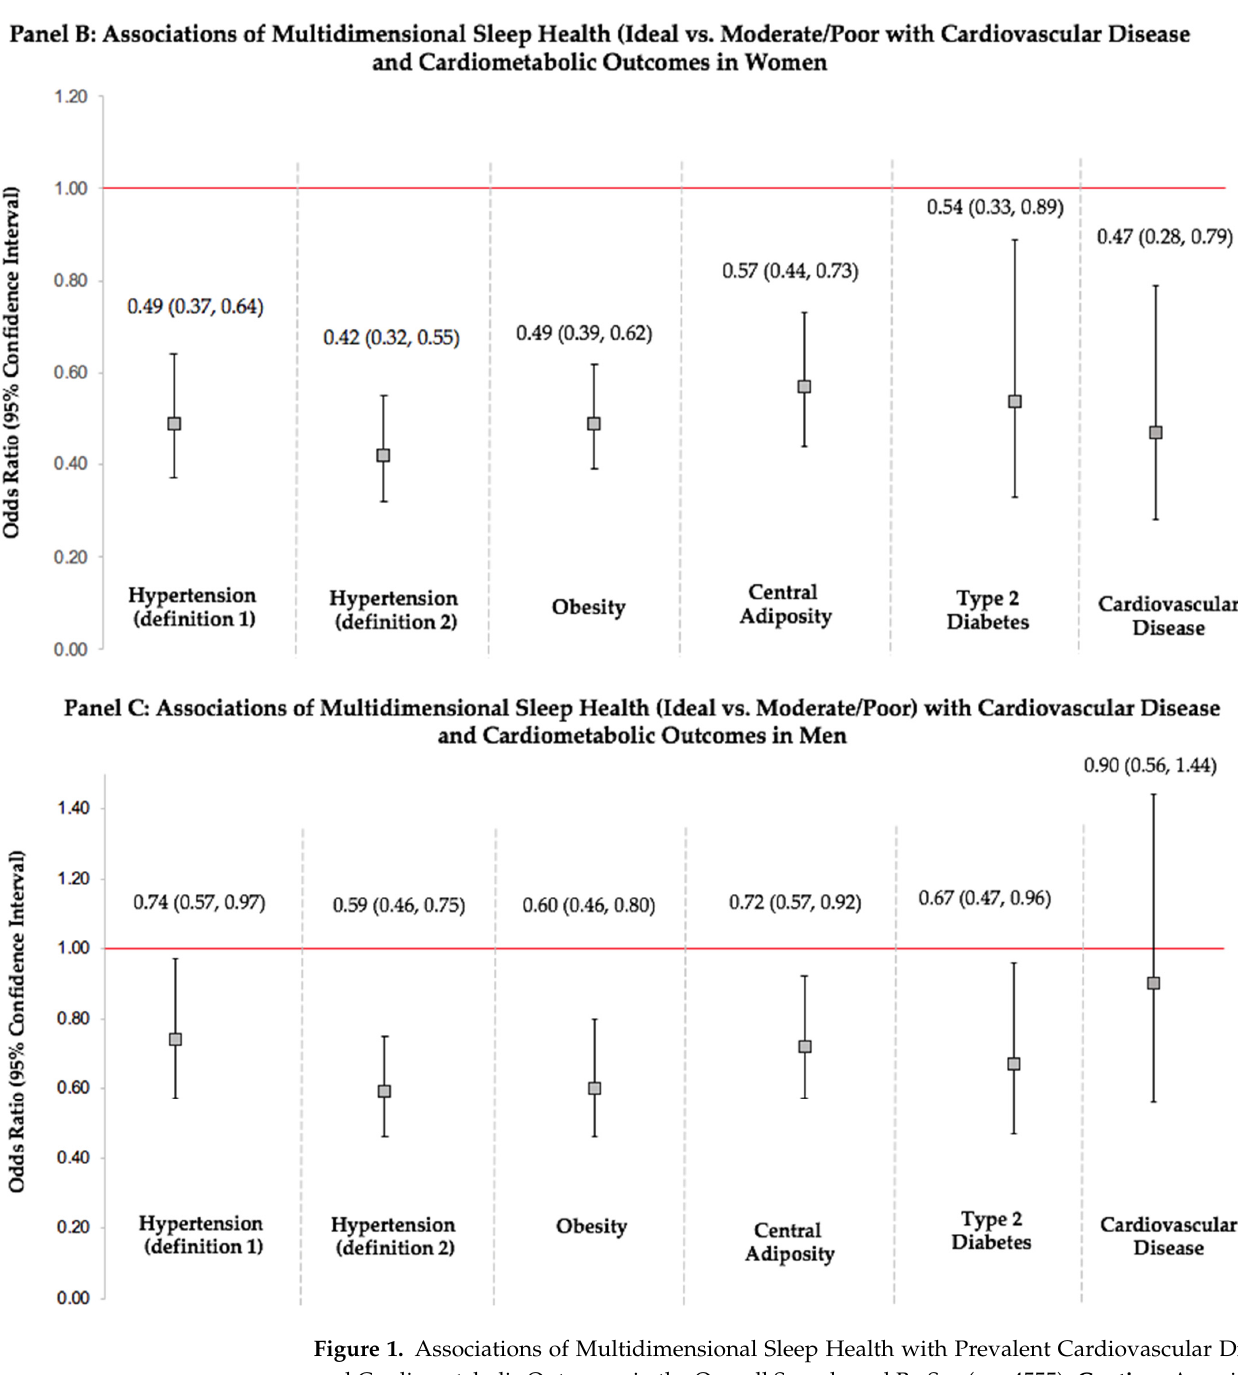
and panels B and C display associations in women and men,